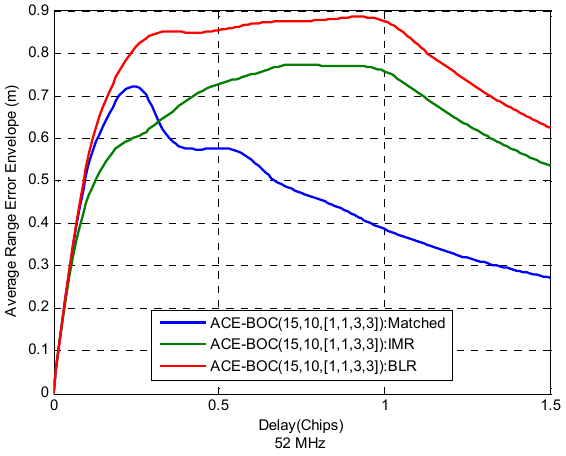
Figure 5. Average range error envelope of ACE-BOC(15,10,[1,1,3,3]), under matched receiving, IMR and BLR. The double-sided receiving bandwidth 52 MHz. MDR is − 5 dB.